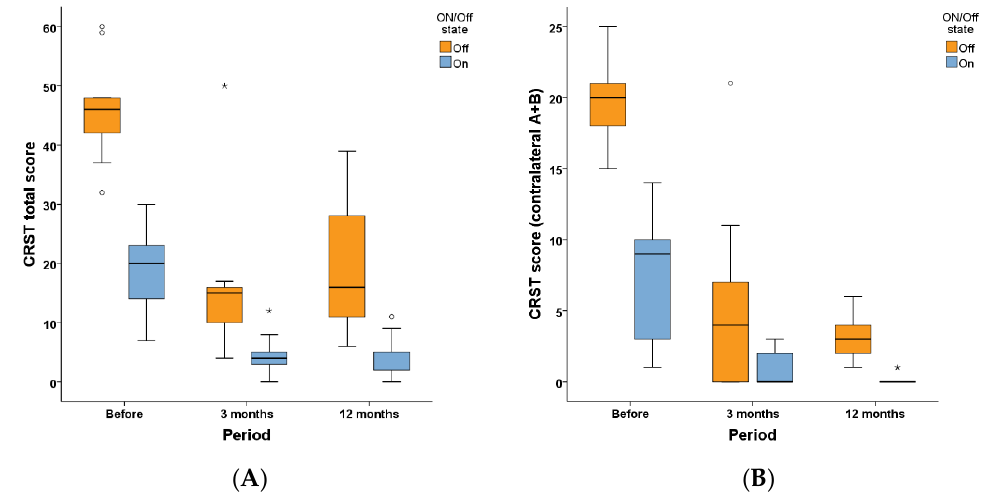
Figure 3. CRST scores before and after MRgFUS Vim ablation. ( A ) Total CRST score at ON and OFF state before and at three months and one year after unilateral Vim ablation by MRgFUS. ( B ) CRST (A + B) score of the contralateral limb at ON and OFF state before and at three months and one year after unilateral Vim ablation by MRgFUS. ◦ and * in the figures represent the outliers of the corresponding group. MDS-UPDRSIII: Movement Disorder Society Unified Parkinson’s Disease Rating Scale part III; CRST: Clinical Rating Scale for Tremor.